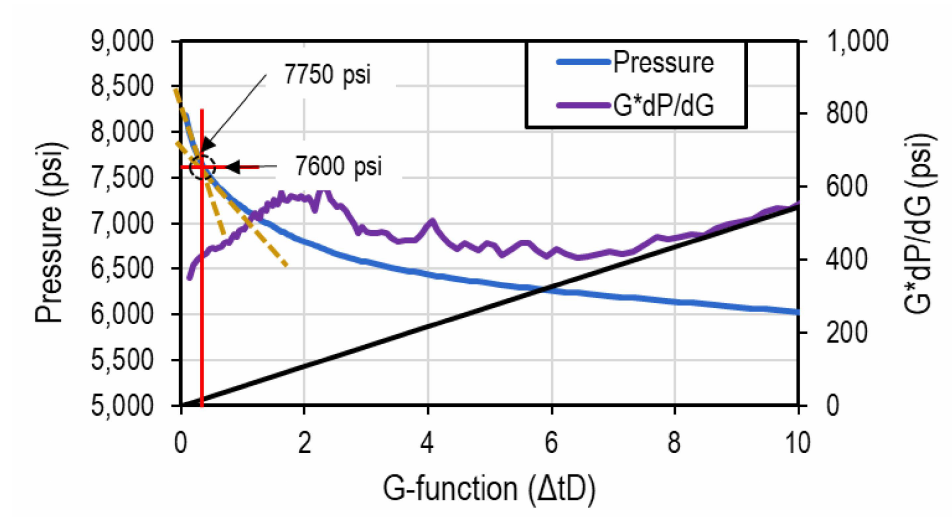
Figure 12. DFIT analysis and G-function plots for Well #1 (Woodford Formation).